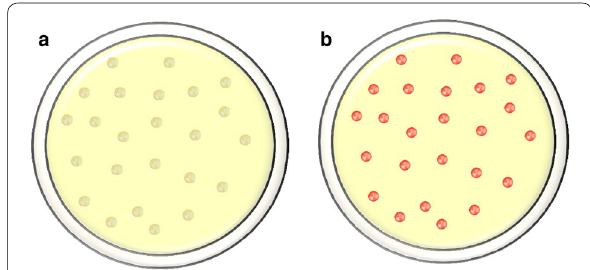
Fig. 1 Colorimetric plate-based screening assay for amine oxidase activity by capture of the hydrogen peroxide produced using 3,3 ′ -diaminobenzidine with peroxidase. a Colonies with D - α -methylbenzylamine as screening substrate. b Identical clones with the L -enantiomer as substrate